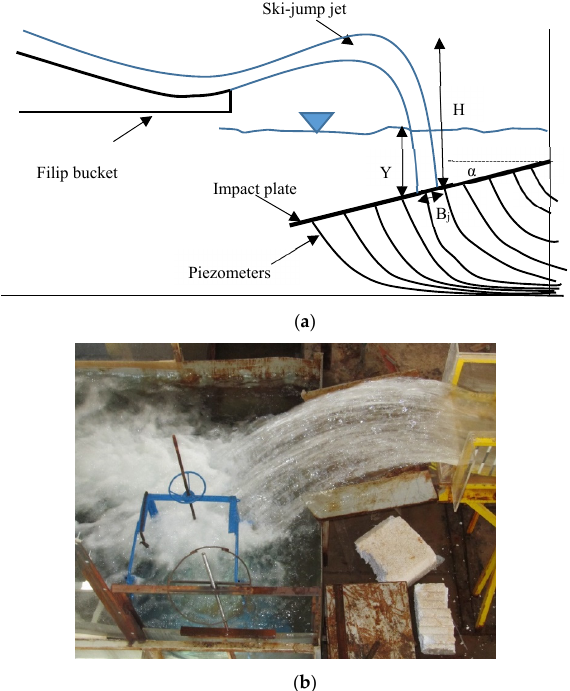
Figure 2. ( a ) Ski-jump, plunging depth, and angle of impact plate; ( b ) jet trajectory of ski-jump and impinge on impact